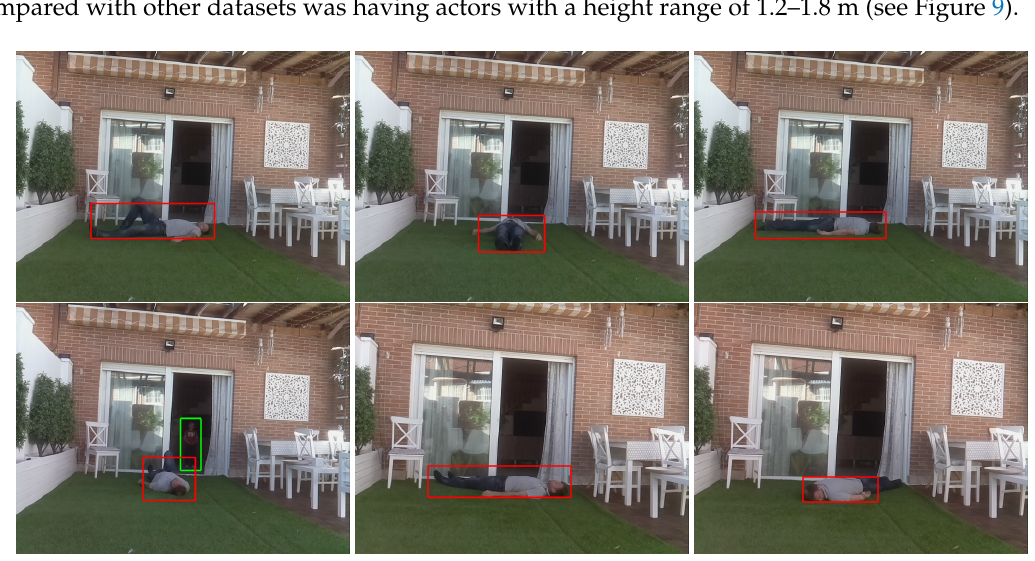
Figure 8. Fallen Person Dataset (FPDS) images with different lying-body